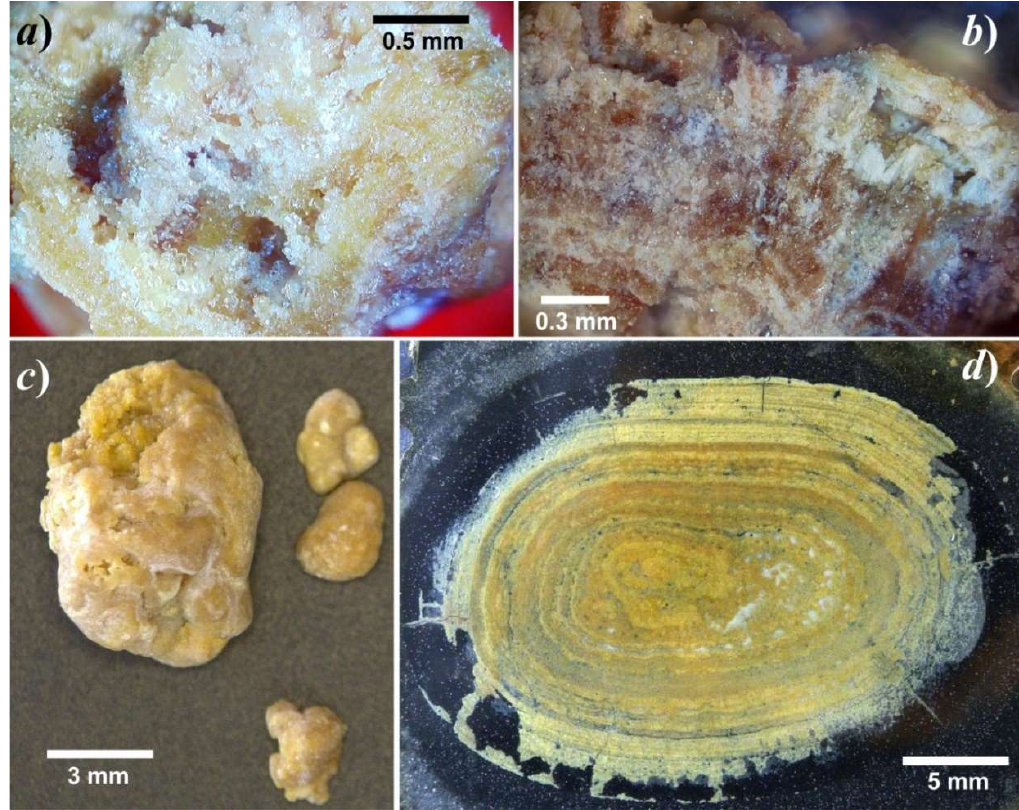
Figure 1. Fragments of urate renal stones: ( a ) monophase renal stone with uricite single crystals; ( b ) fragment of the urate renal stone with yellowish uricite zones and white tinnunculite zones; ( c ) typical urate renal stones excreted at one time; and ( d ) thin section of large urate renal stone, showing zonal distribution of uricite (light yellow) and organic substance.